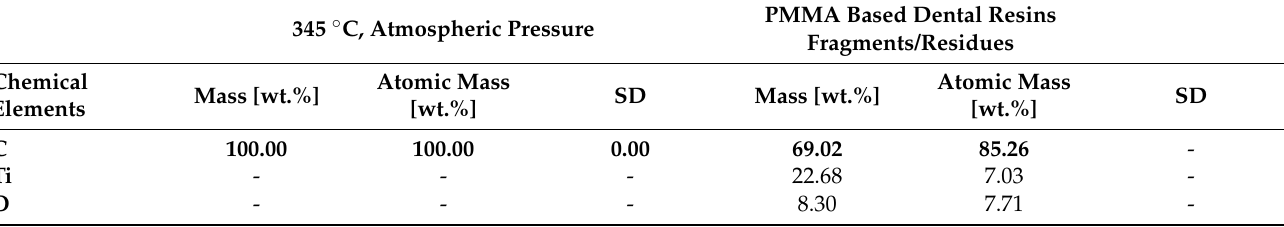
Table 9. Percentages in mass and atomic mass of PMMA based dental resins fragments/residues before and after pyrolysis at 345 °C, atmospheric pressure, in pilot scale, by EDX technique.